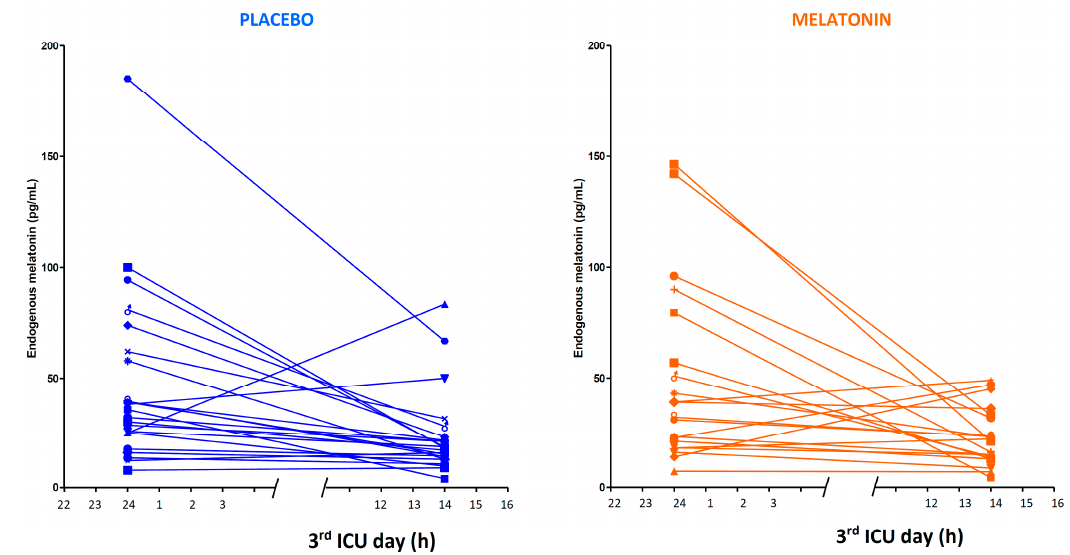
Figure 1. Endogenous melatonin secretion in the 3rd day of ICU measured at midnight and 14:00 h, in patients assigned to the two treatments groups before placebo or melatonin tablet administration. The median (25; 75 percentiles) values were 33.8 (25; 62) vs. 32.0 (21; 57) pg/mL at midnight and 16.8 (13; 23) vs. 21.0 (13; 32) pg/mL at 14:00 h, for the two treatment groups, respectively, without significant differences.